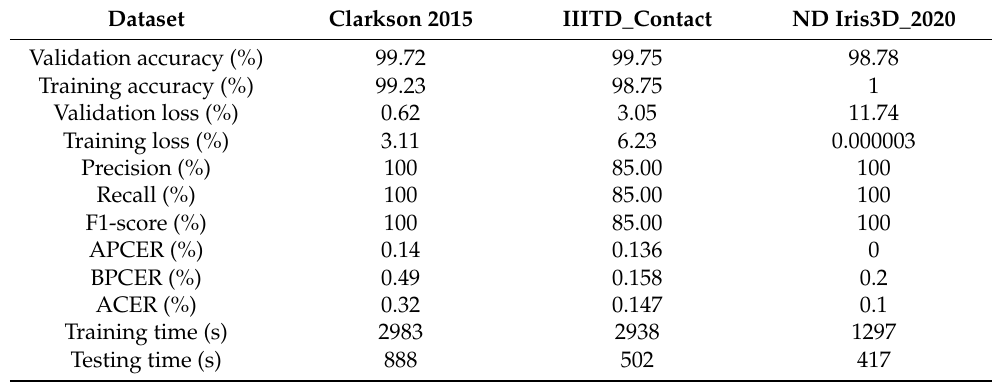
Table 4. Performance evaluation of the VGG16 model for iris liveness